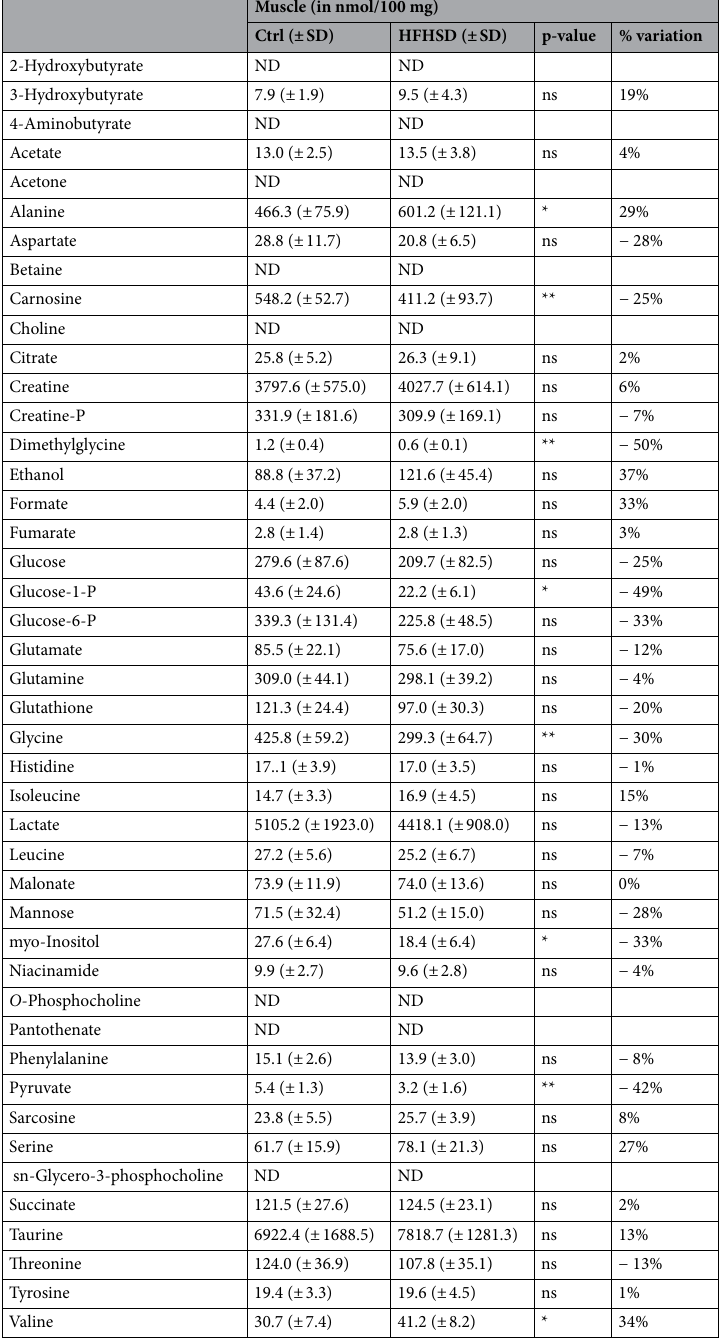
Table 6. Metabolite concentrations measured by NMR in the gastrocnemius muscle of SD and HFHSD mice. Results are expressed as mean ± standard deviation (SD) and are in nmol/100 mg of gastrocnemius muscle. Data are mean of n = 8 mice per group; Results of unpaired two-tailed t-test are indicated as non-determined (ND), non-significant (NS), p < 0.05 (*), p < 0.01 (**), p < 0.001 (***) and p < 0.0001 (****). Percentages of variation between HFHSD and control fed mice are